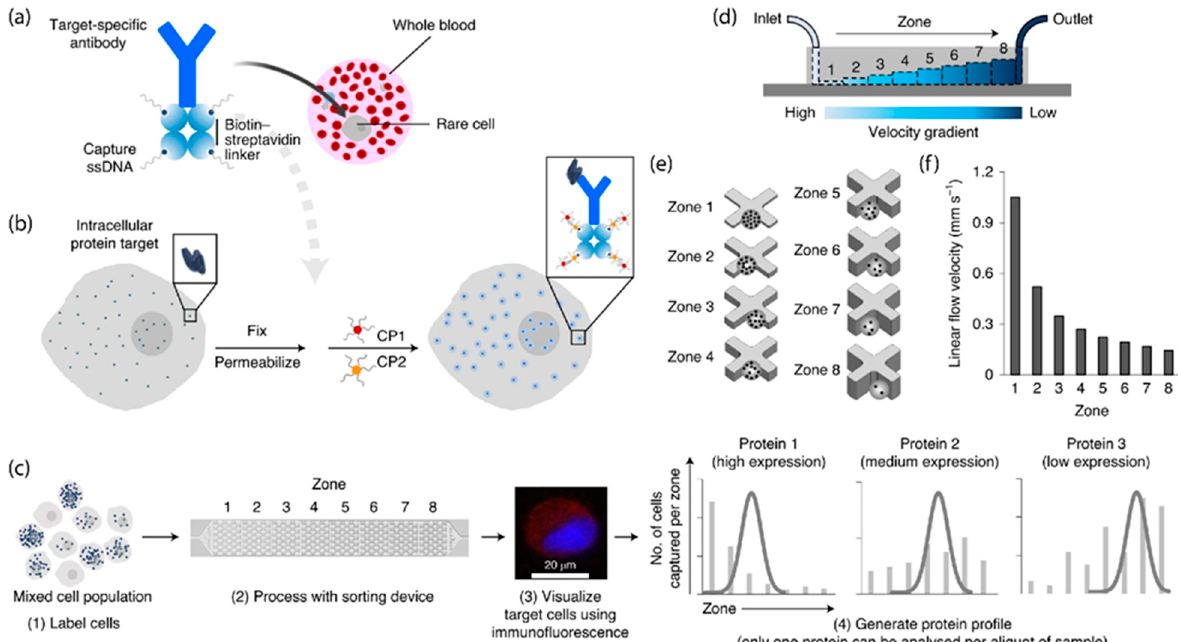
Figure 13. Magnetophoretic cell ranking based on the intercellular protein expression. ( a ) Labeling process. ( b ) Preparation of the cells for intercellular update. ( c ) Process flow. ( d ) Illustration of the vertical cross section of the device to selectively capture cells based on their different magnetic contents. ( e ) Visualization of the ferromagnetic features in each capture zone. ( f ) Average flow velocity in each capture zone. Reproduced with permission [107]. Copyright 2021 Nature Publishing Group.